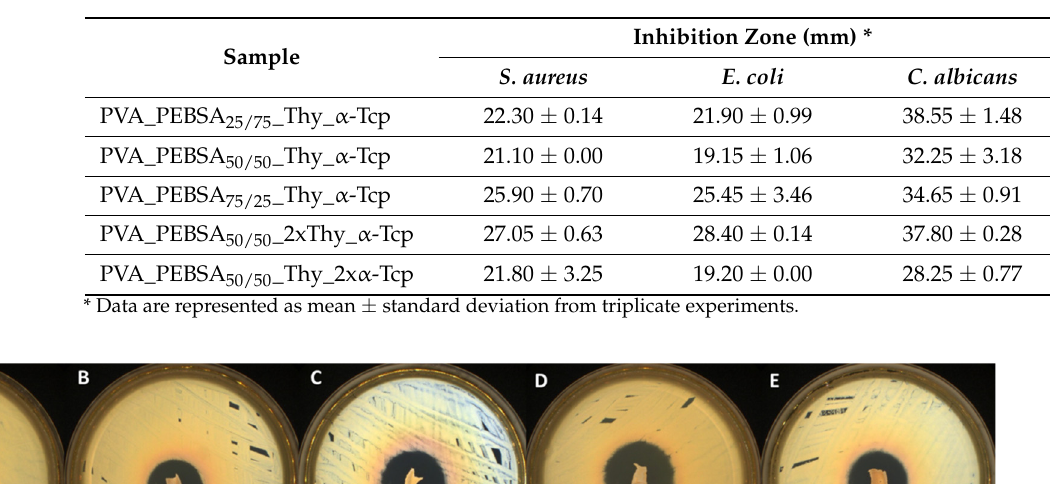
α -Tcp, 25/75 _Thy_